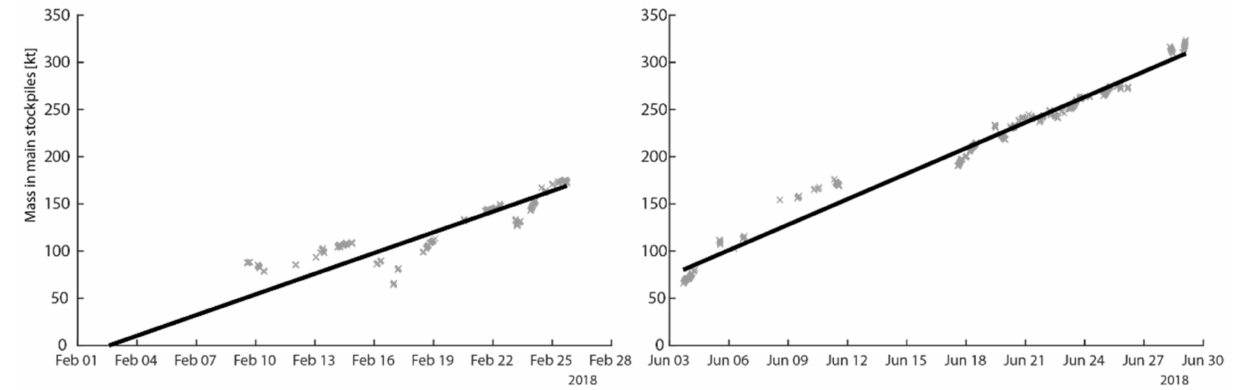
Figure 7. Cumulative ore mass of the two main stockpiles at the median ore level based on the measured net ore flow. The accumulation of ore at a constant level means that more inflow is measured than outflow, which indicates inaccuracy at the